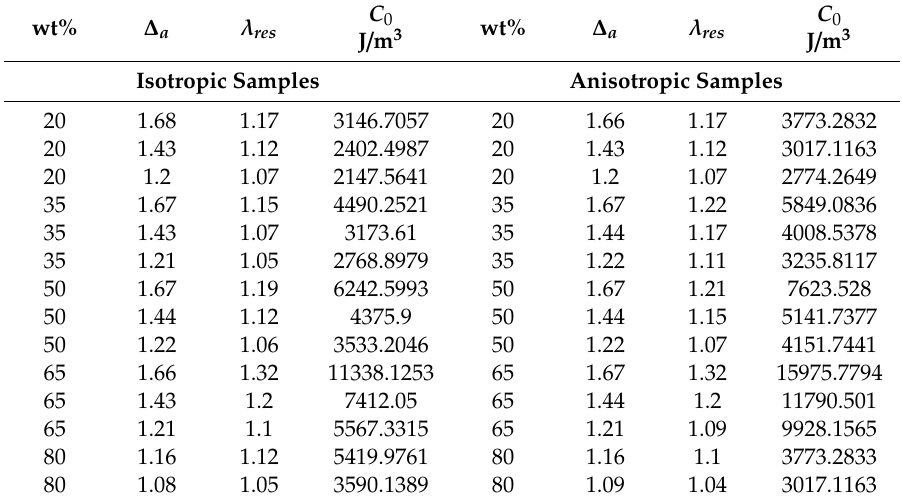
Table4. Estimatedmaterialconstantvaluesof C 0 obtainedbyfittingexperimentaldata. Thelistedvalues of ∆ a and λ res were recorded for each loading–unloading cyclic experimental test with B = 52.2